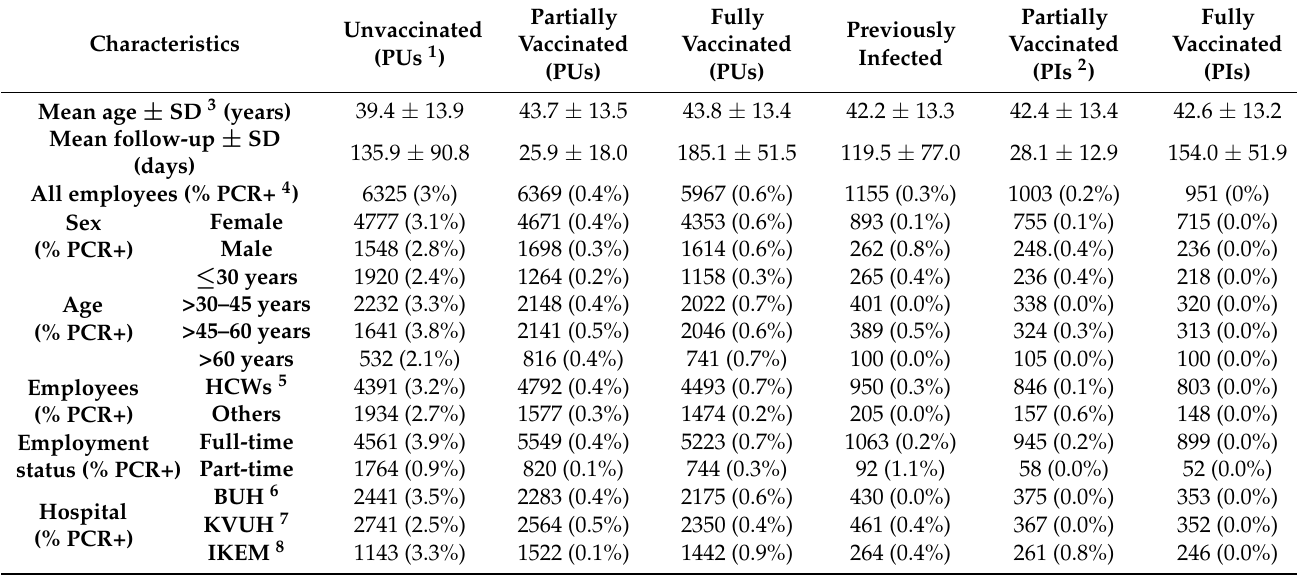
Table 1. Baseline characteristics of study participants in cohorts.